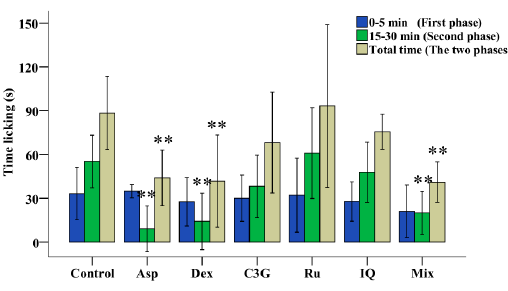
Figure 4. Antinociceptive activities of C3G, Ru and IQ in mice. Values with asterisks are significantly different (* p < 0.05; ** p < 0.01) from those in the control group.